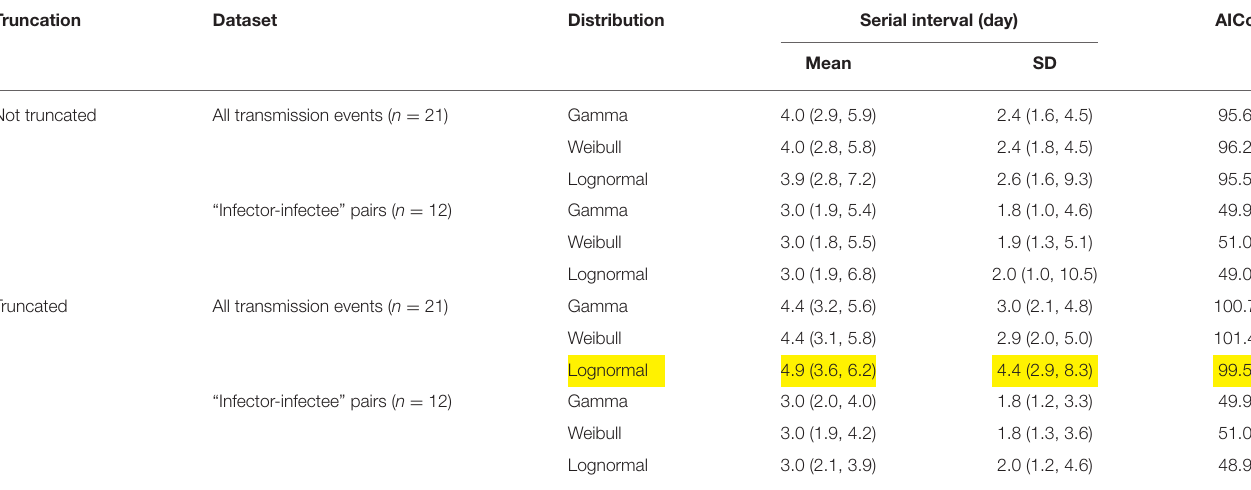
TABLE 1 | Summary of the estimates of the serial interval (SI) mean and standard deviation (SD) from three different distributions. Truncation Dataset